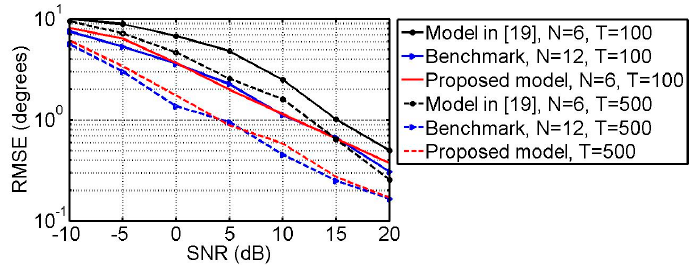
Figure 7. RMSE of the polarization parameter estimates versus SNR with T = 100 and T = 500.